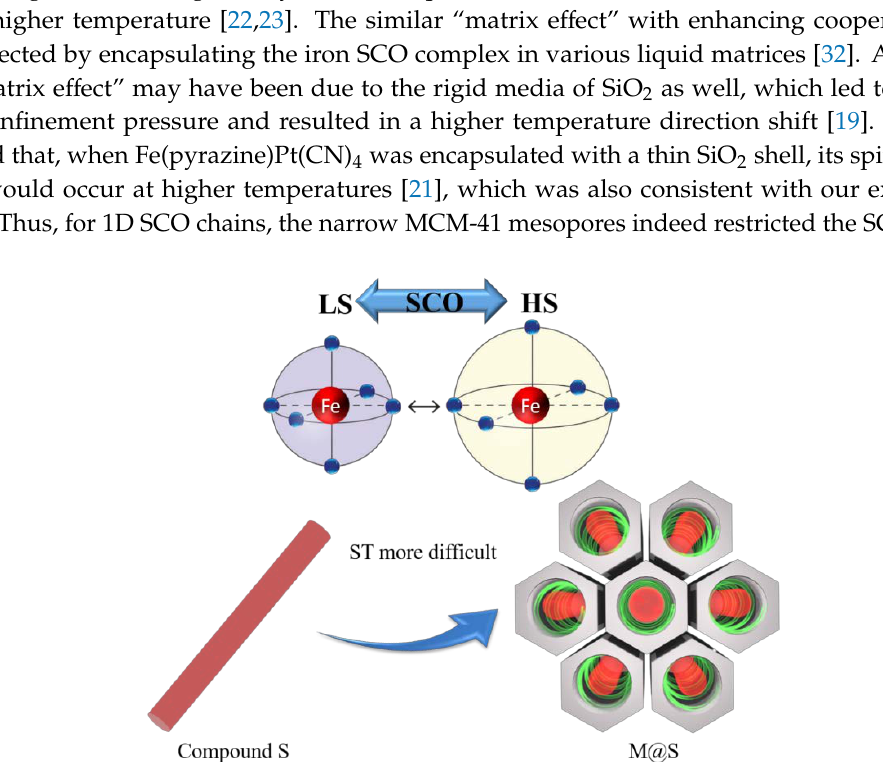
Figure 6. Schematic presentation of the “matrix effect” from the walls of MCM-41.